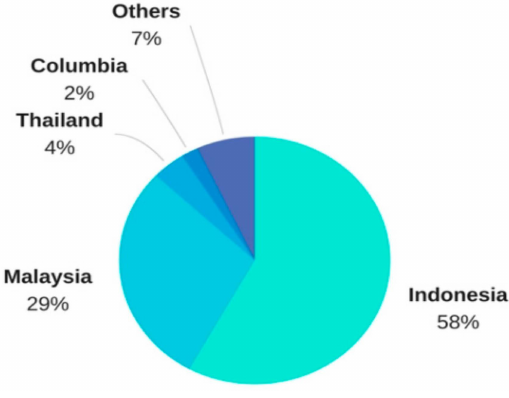
Figure 1. Palm oil production by country, 2017